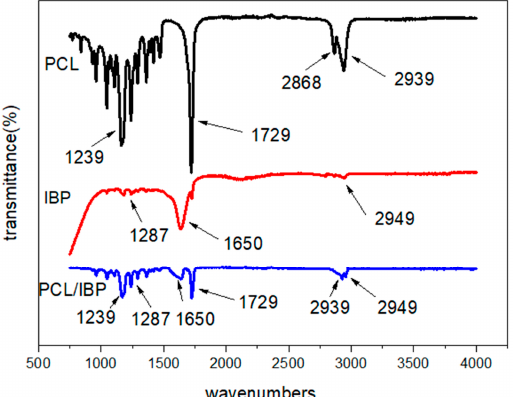
Figure 3. Fourier-transform infrared spectra (FTIR) of PCL membranes, IBP powder, and IBP-coated PCL